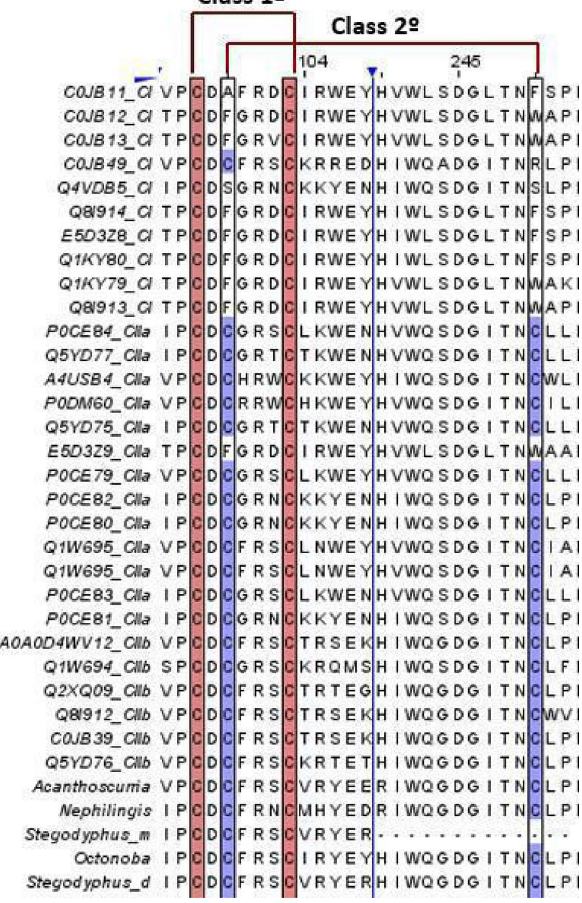
Figure 4. Spider venom and midgut SMaseD multiple sequence alignment and their classification by cysteine conservation. SMaseD of class I, class IIa and class IIb from L. venom gland were aligned against SMaseD from abdomen A. geniculata , midgut N. cruentata , digestive fluid S. mimosarum, and whole body S. dumicola and O. yesoensis in multiple sequence alignment (MUSCLE software), to classify the SMaseD found in the